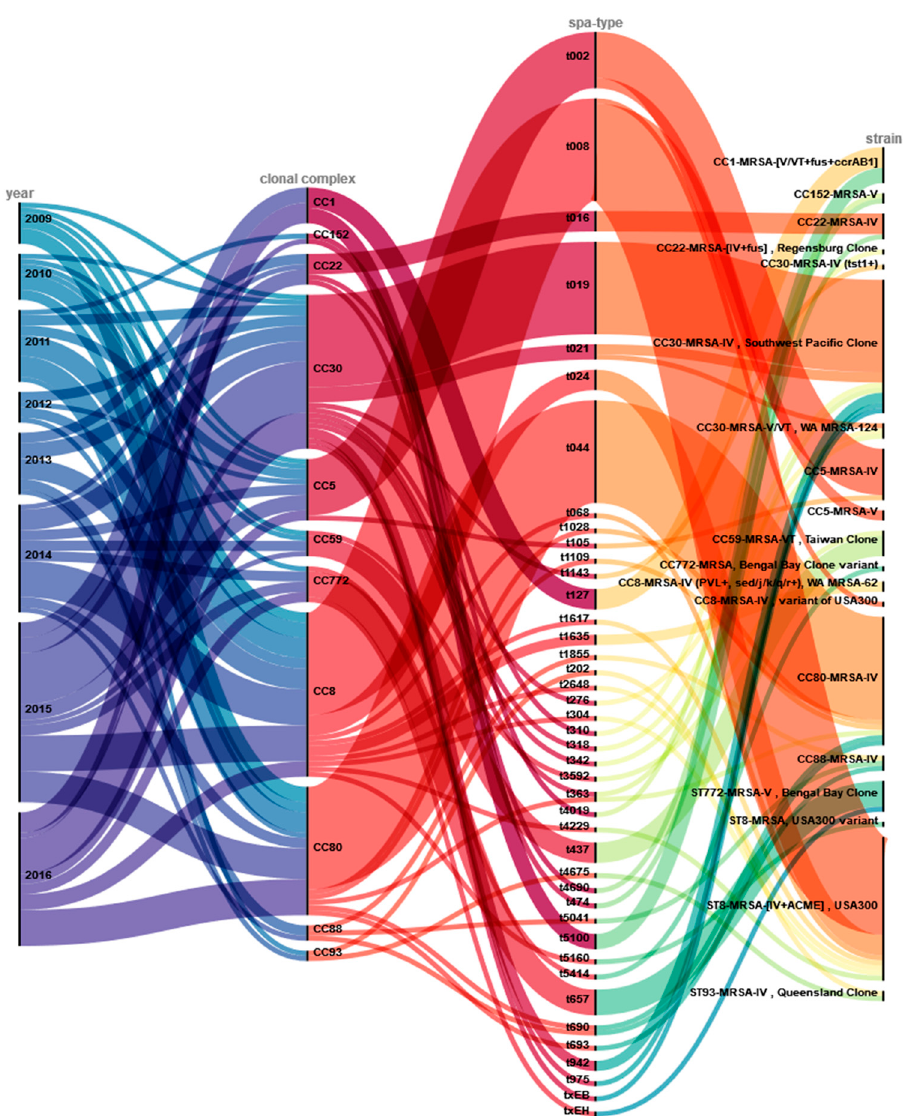
Figure 2. Overview of genotyping results and assignment to clonal lineages. This alluvial diagram depicts the year of isolation (year) and the distributions of genotypes (clonal complex; spa -type), as well as microarray-based strain assignments (strain). Colored lines visualize and link the allocation of these results.